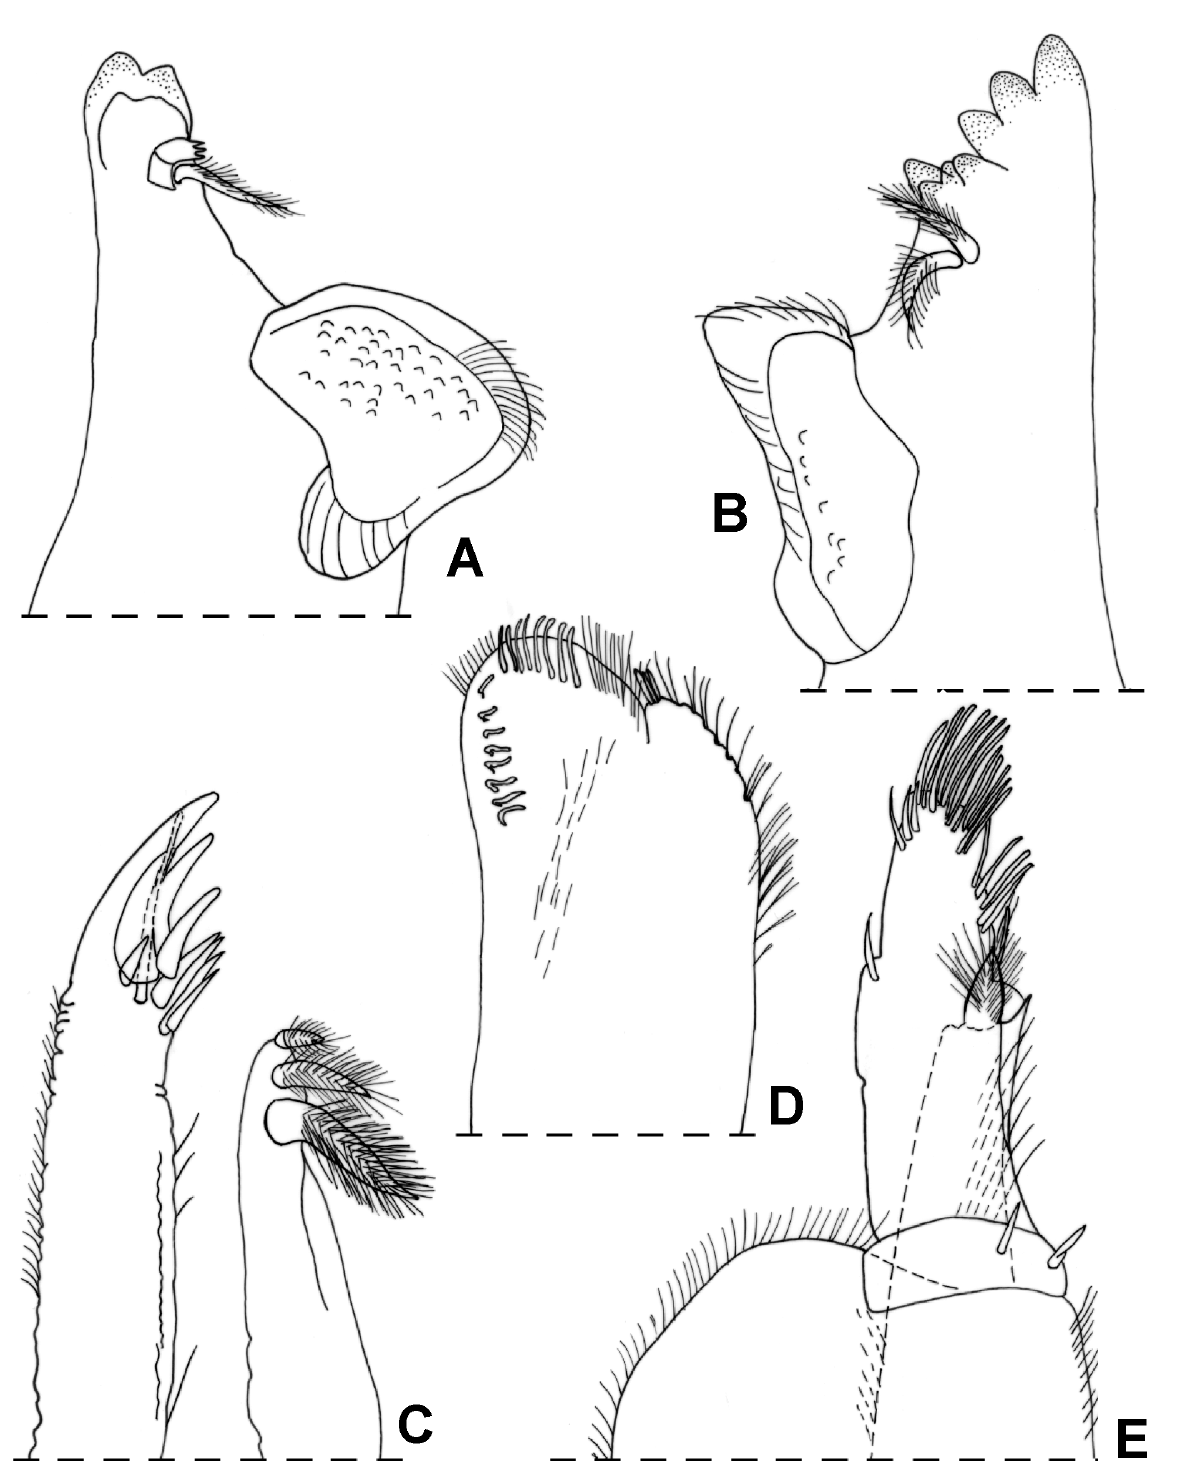
Fig. 19. Miktoniscus longispina Reboleira & Taiti sp. nov. from Gruta dos Bolhos, Cesaredas Plateau, paratype, ♂. A . Right mandible. B . Left mandible. C . Maxillula. D . Maxilla. E .